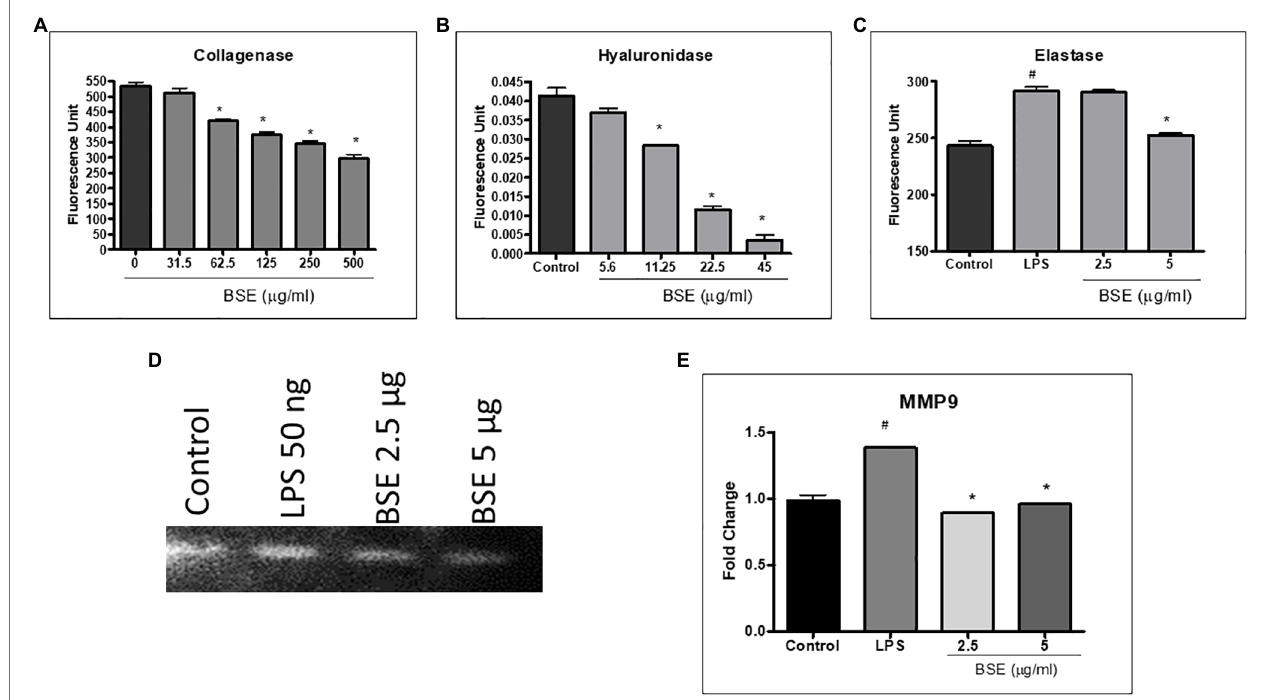
FIGURE 4 | Effect of BSE on (A) collagenase enzyme inhibition, (B) hyaluronidase enzyme inhibition, and (C) elastase enzyme inhibition. (D) and (E) MMP-9 in cell lysates of RAW 264.7 macrophage cells induced with LPS detected by zymography. # p < 0.05 compared to control; ### p < 0.005 compared to control; * p < 0.05 compared to the negative control (vehicle control for collagenase and hyaluronidase enzyme inhibition and LPS for elastase enzyme inhibition and